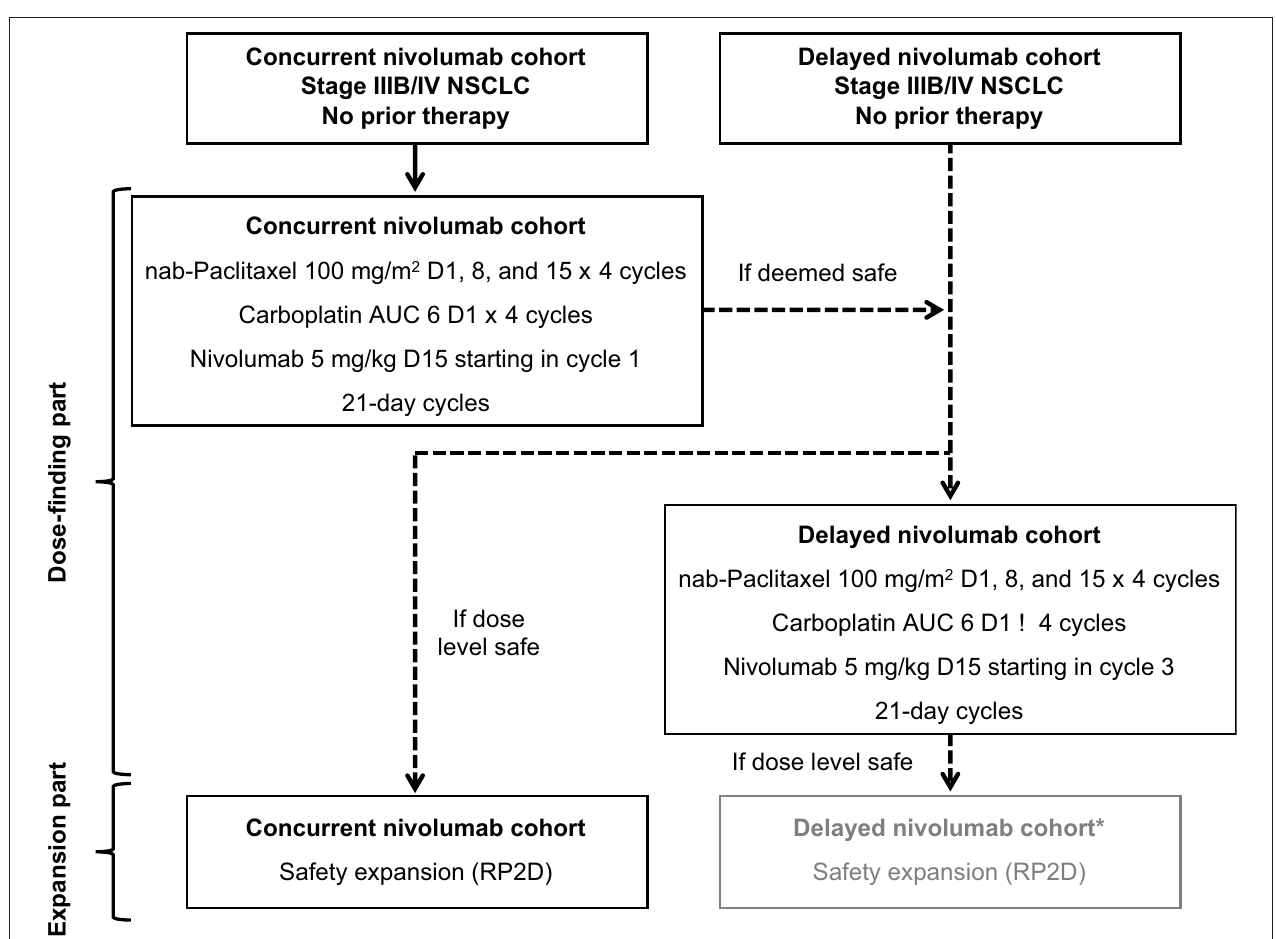
FIGURE 1 | Study design. *The expansion part of the delayed cohort was not pursued because the survival outcomes in the dose-finding part of this cohort were not as encouraging as those in the concurrent cohort and the safety profile with concurrent nivolumab administration was acceptable. AUC, area under the curve; NSCLC, non–small-cell lung cancer; RP2D, recommended part 2 dose.